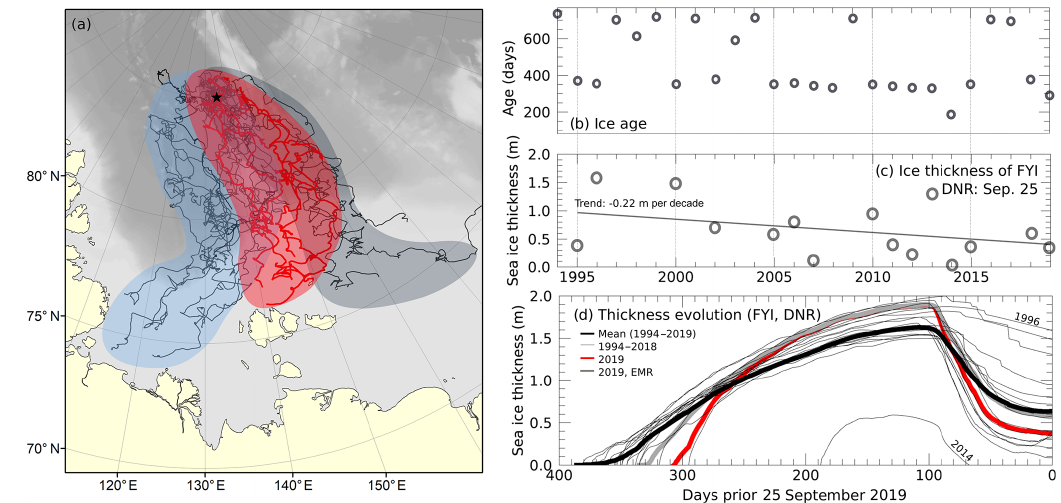
Figure 7. Ice origin, age and thickness of the DNR ice on 25 September between 1994 and 2019: (a) trajectories from the past 26 years separated by the region of origin: (i) blue: Laptev Sea; (ii) red: region north of the New Siberian Islands; (iii) grey: East Siberian Sea. (b) Age of the ice in the DNR region on 25 September of each year. (c) Thickness of DNR FYI based on a thermodynamic model (Methods). (d) Annual cycle of FYI growth and